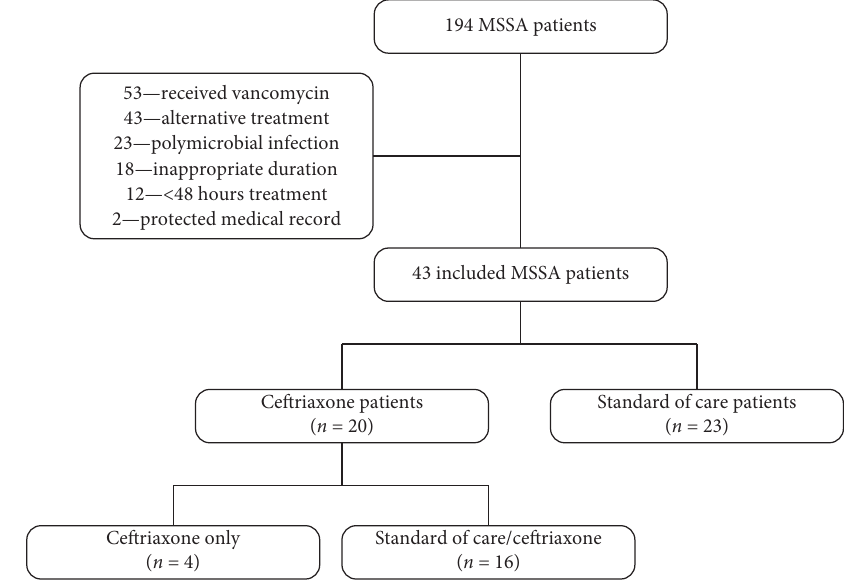
Figure 1: Flow diagram for study participants. Table 1: Baseline